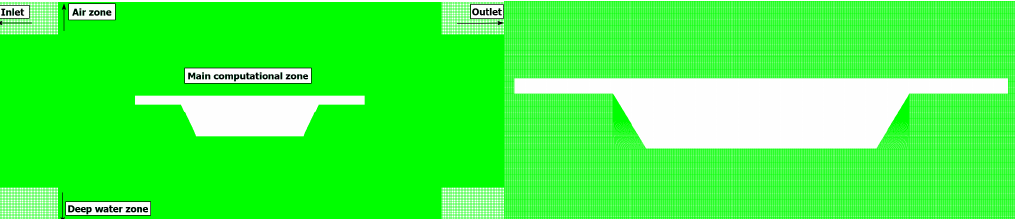
Figure 5. Example of grid mesh.